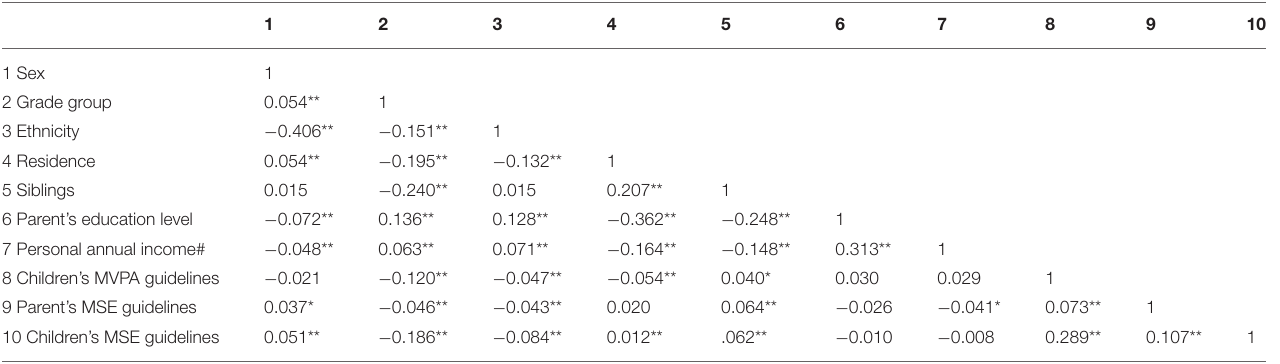
TABLE 2 | Bivariate correlations among study